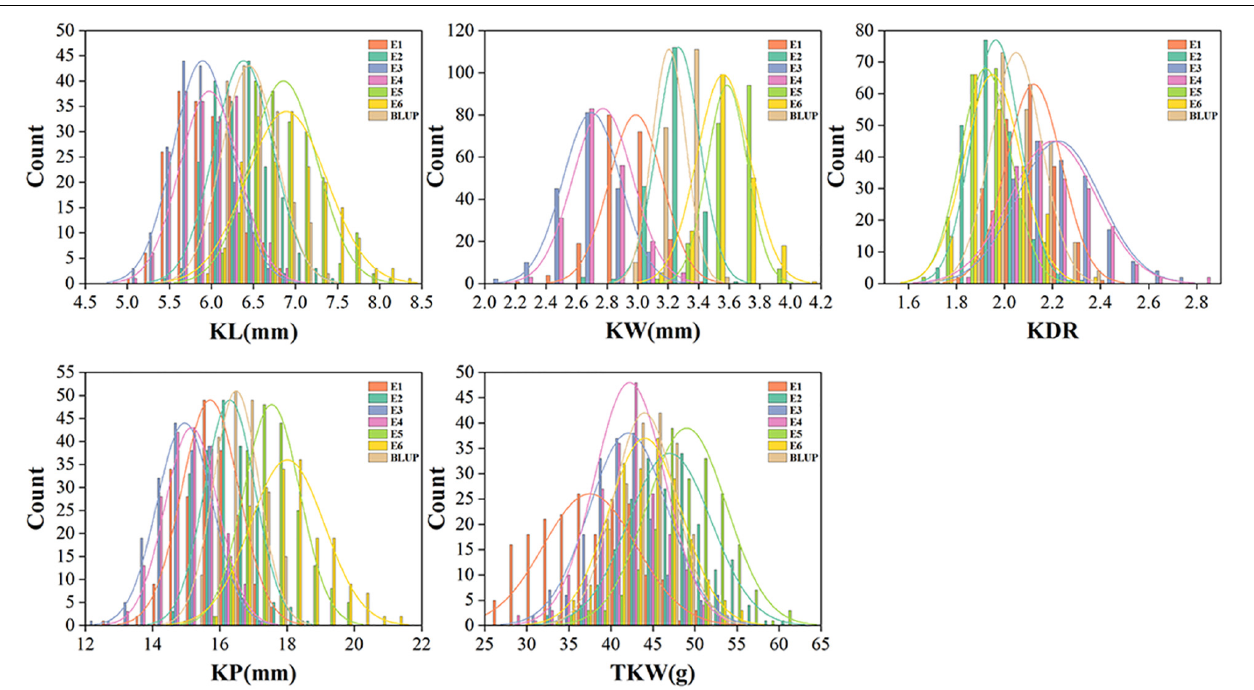
FIGURE 1 | Distribution of the kernel traits in 198 wheat association panel. KL, kernel length; KW, kernel width; KDR, kernel diameter ratio; KP, kernel perimeter; TKW, thousand kernel weight.